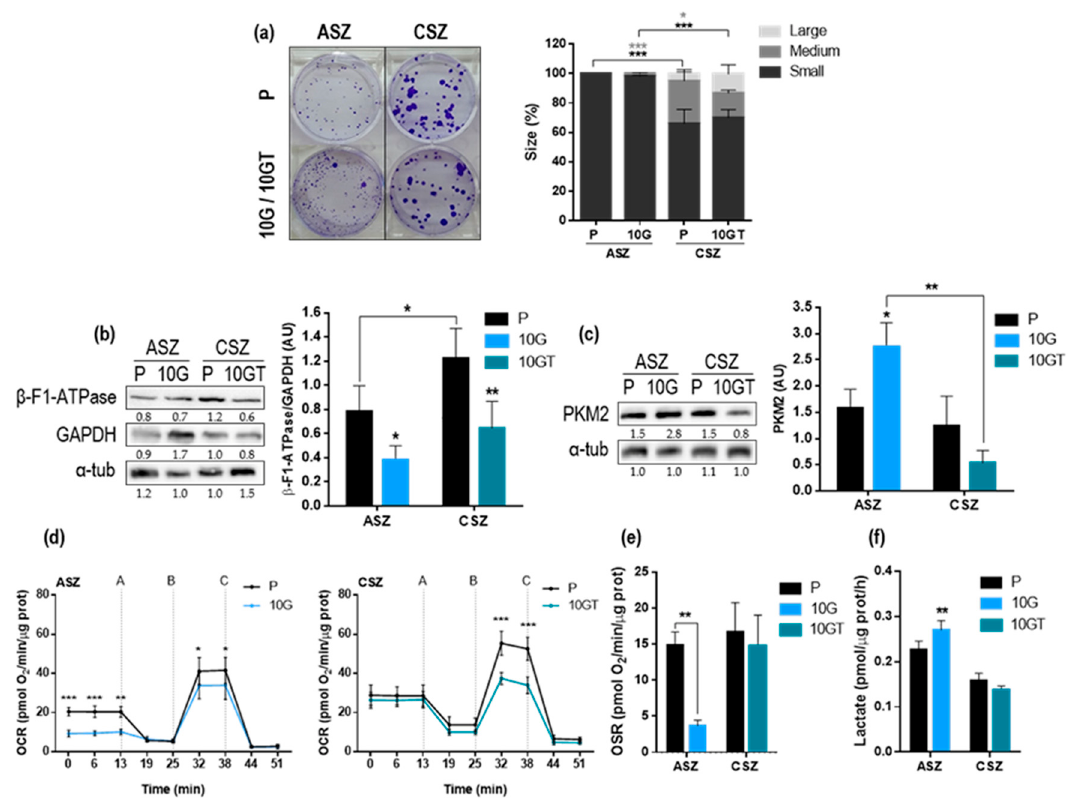
Figure 2. Proliferation capacity and metabolic characterization of Basal Cell Carcinoma (BCC) cells: ( a ) For the clonogenic assay, 50 cells/mL were seeded in each plate of 6 wells, and 7 days later, the colonies formed were stained with 0.2% crystal violet. Colonies were classified in relation to their diameter: small (<1 mm), medium (1–2 mm), and large (>2 mm) ( n = 3). ( b ) Expression of the metabolic markers β -F1-ATPase and GAPDH (glyceraldehyde-3-phosphate dehydrogenase) analyzed by western blot (WB); alphatubulin was used as loading control; and the ratio of β -F1-ATPase/GAPDH indicates the use of glucose by the cells, which was significantly lower in the resistant comparing to that of P cells ( n = 5). ( c ) Pyruvate kinase M2 (PKM2) levels were higher in 10 G of ASZ compared to the P cells ( n = 3). ( d ) Oxygen consumption rate (OCR) measurements over time (min) were determined by using an extracellular flux analyzer after the sequential addition of oligomycin (A), 2,4-Dinitrophenol (DNP) (B), and rotenone + antimycin (C) ( n = 4). ( e ) Oligomycin-sensitive respiration, which represents the activity of oxidative phosphorylation (OXPHOS), was calculated as basal respiration – oligomycin respiration ( n = 4). ( f ) Rates of lactate production determined spectrophotometrically ( n = 6). Values were represented as mean ± SD (* p < 0.05; ** p < 0.01; *** p < 0.001).